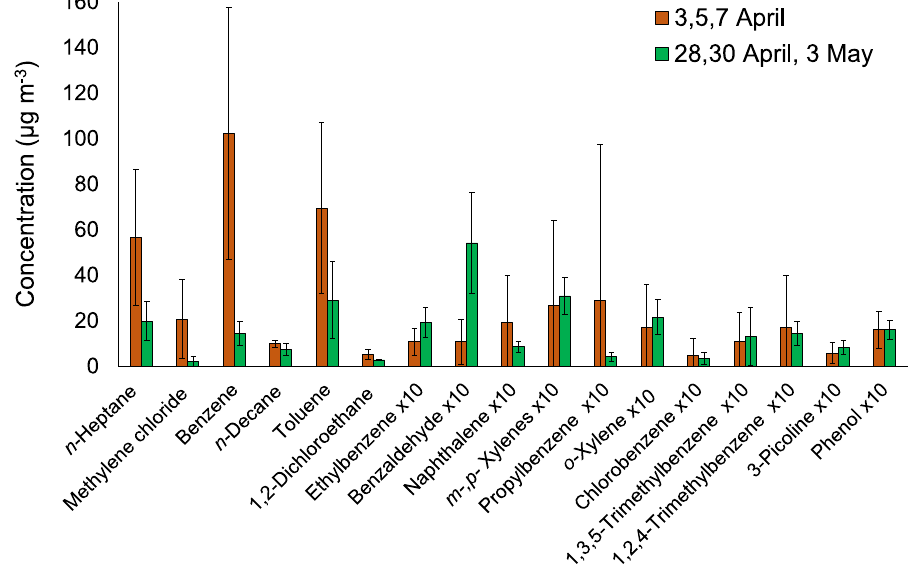
Figure 3. Variations of the VOCs concentrations (mean of the three sampling days ± SD) in spring sampling periods during heating and non-heating season.